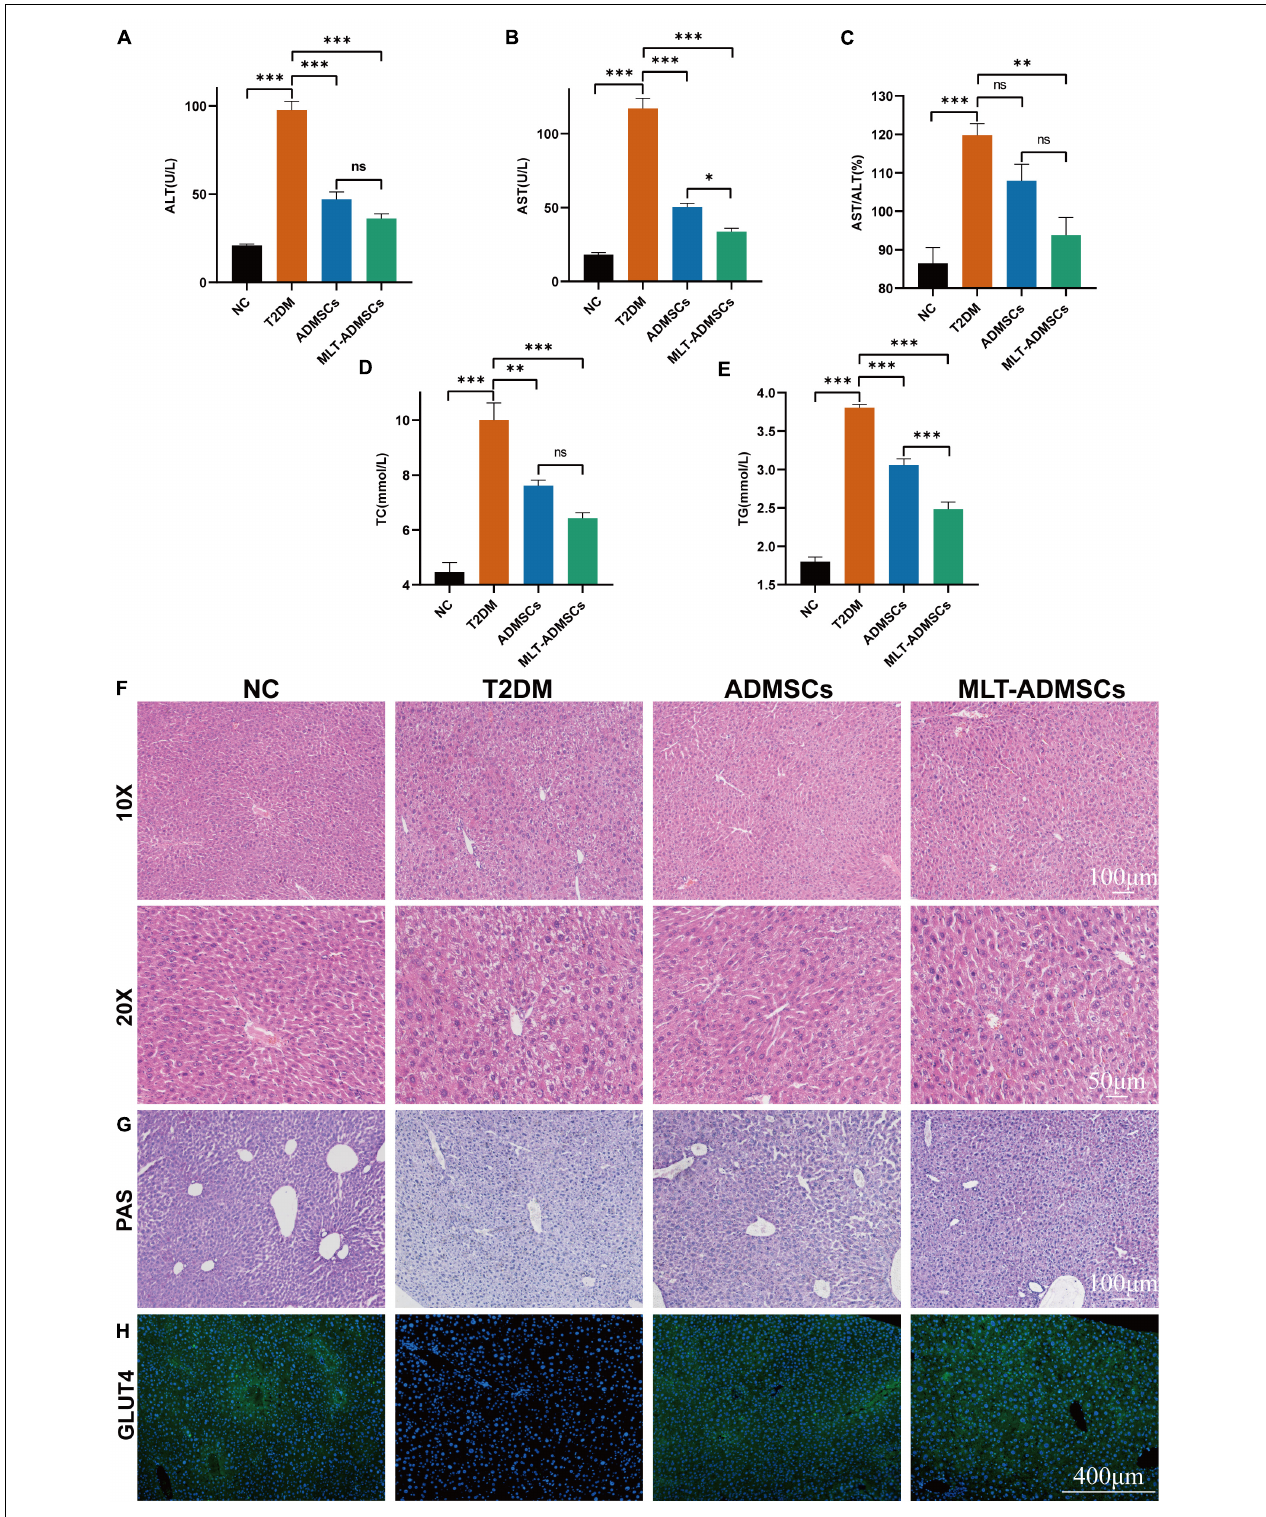
FIGURE 4 | MLT enhanced the recovery effect of ADMSCs on glucose metabolism in T2DM mice and repaired the liver damage and lipid metabolism disorders caused by T2DM. (A) Serum ALT. (B) Serum AST. (C) AST/ALT. (D) Serum TC. (E) Serum TG. (F) Liver H&E staining. (G) Liver PAS staining. (H) Liver immunofluorescence GLUT4. Values in this figure are the mean ± SE; n = 10 mice per group; ns > 0.05, ∗ p < 0.05, ∗∗ p < 0.01, ∗∗∗ p < 0.001 determined by a repeated-measures ANOVA.